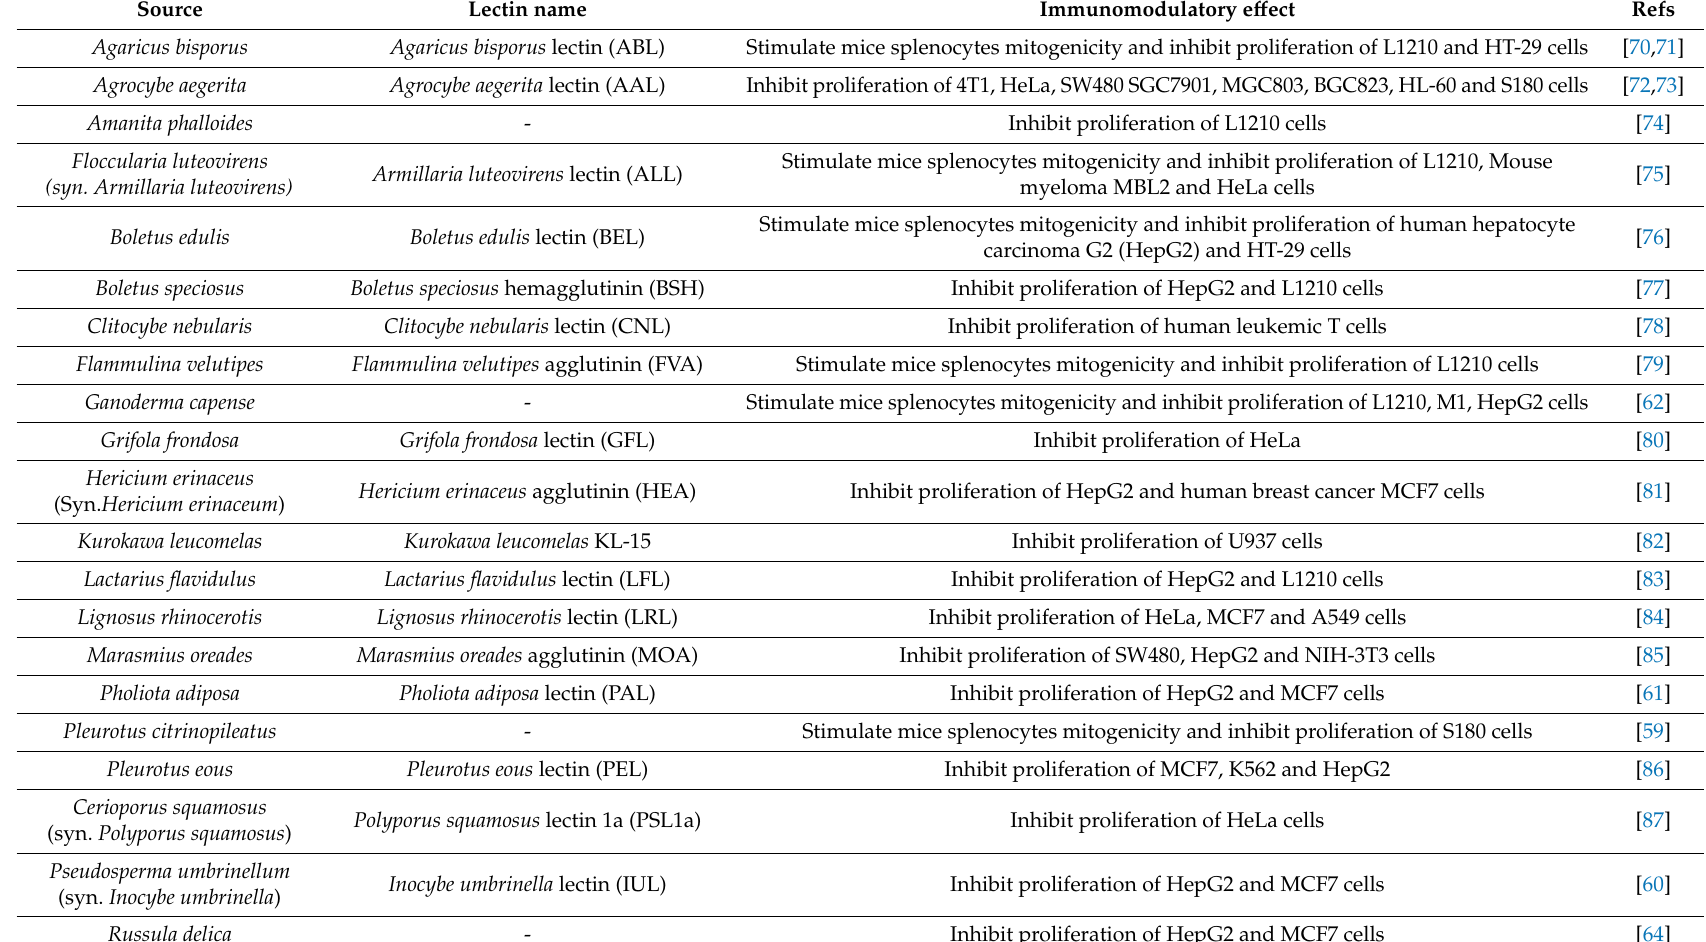
Table 3. Major immunomodulatory lectins from medicinal mushrooms and their immunomodulatory e ff